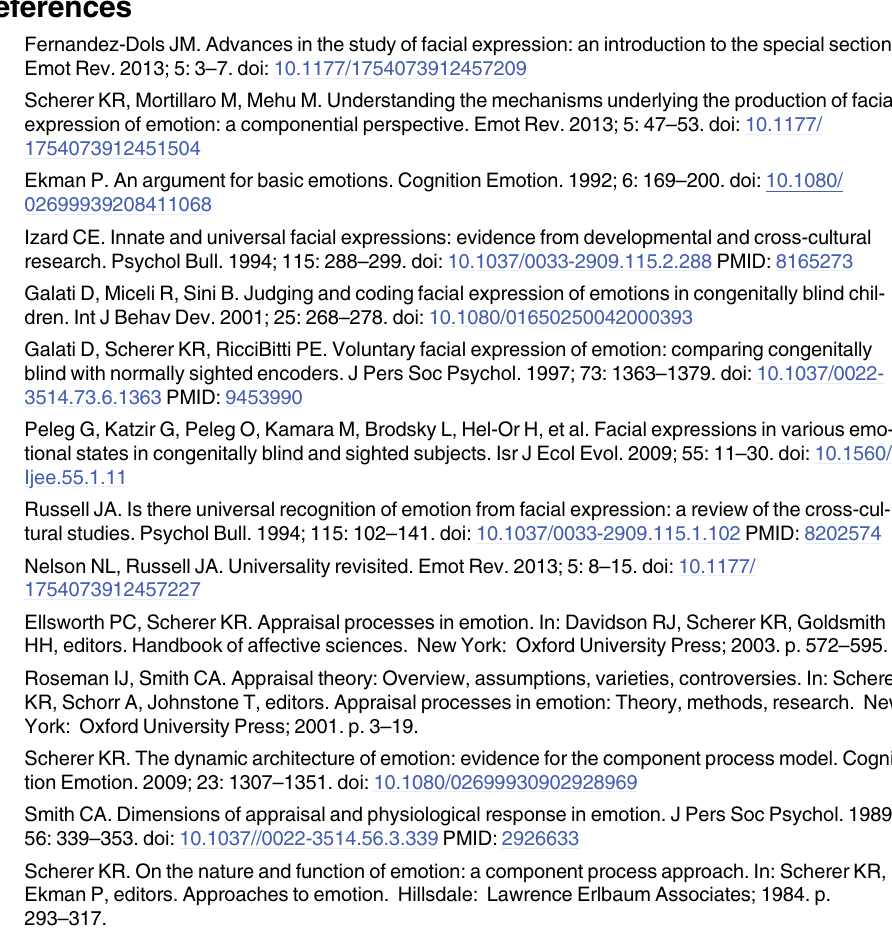
S1 Table. Means (M) and Standard deviations (SD) of the Time Intervals of each Facial Region of Experiment 1. S2 Table. Means (M) and Standard deviations (SD) of the Time Intervals of each Facial Region of Experiment